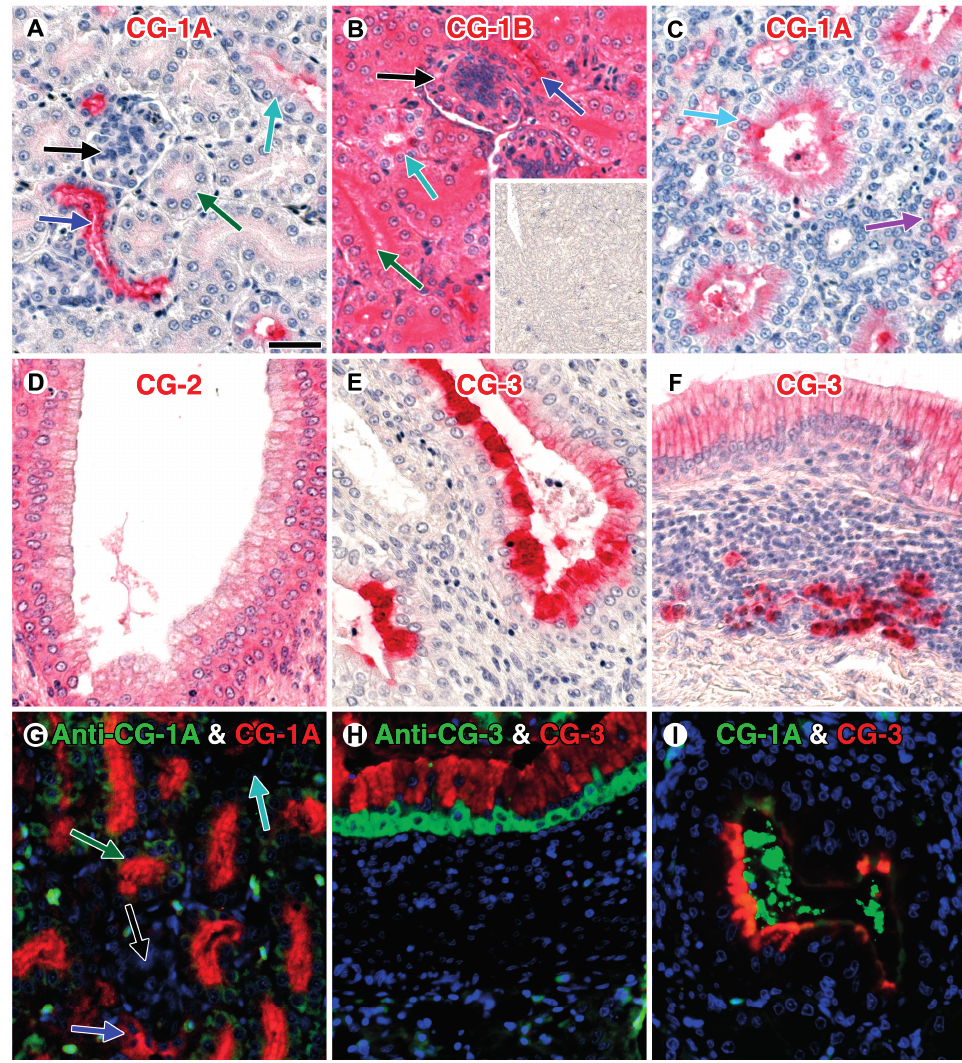
Figure 10. Galectin histochemical detection of accessible binding sites for tissue lectins in the kidney cortex ( A , B ), medulla ( C ), secondary branches of the ureter ( D , E ) and the ureter ( F ). The color coding of the arrows follows the segmental coloring for cortex and medulla (top, right). An examplary control for inhibition by the cognate sugar is shown as inset in panel B. Very distinct staining is detected on apical surfaces in the epithelial lining of renal tubule segments in the cortex for CG-1A and for CG-3 in the apical region of secondary branches of the ureter (E). Co-localization of galectin and accessible binding sites by fluorescence microscopy in cortex ( G ) and ureter ( H ) revealed availability of reactive sites. Sequential application of two fluorescent CGs disclosed regional specificity of binding sites for CG-1A in the ureter ( I ). Mostly lumen and small areas of the epithelium (CG-1A) and apical surface of the epithelium (CG-3) were positive. For technical details of galectin labeling and of the galectin histochemical staining protocol, please see [111–113]. Bar = 25